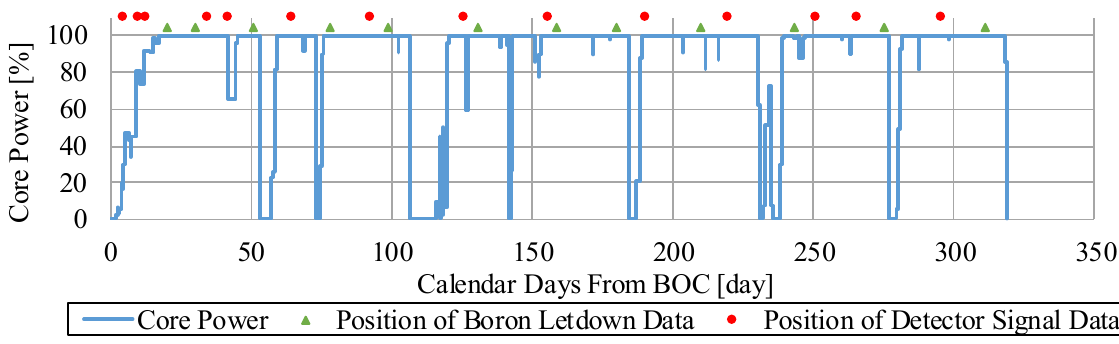
Figure 4. Cycle 2 Operation Diagram.